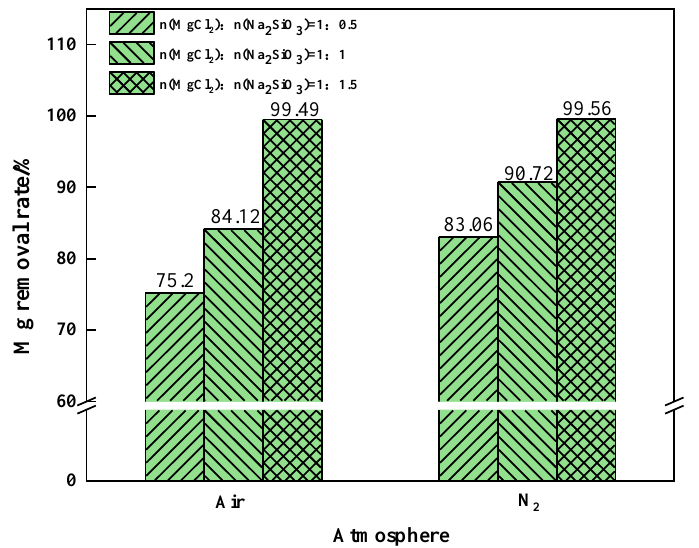
Figure 17. The effect of the phase transition atmosphere on the Mg removal rate.